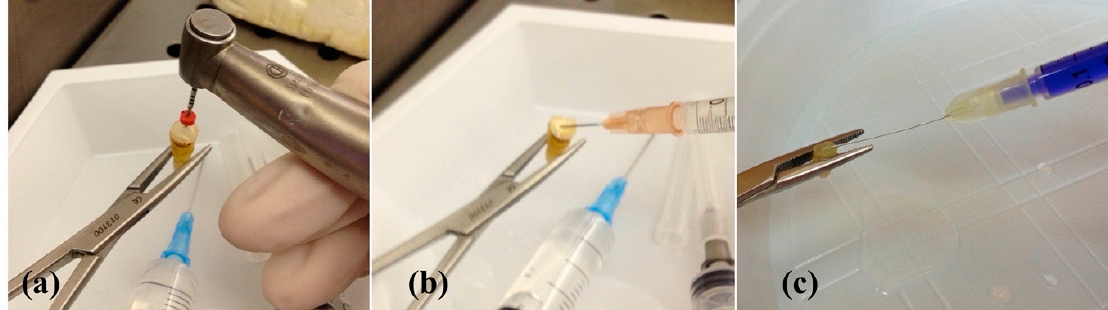
Figure 1. ( a ) Mechanical preparation with a file F2 of the ProTaper® system (Ø = 0.25 mm); ( b ) irrigation of a root canal with 5% of sodium hypochlorite (NaOCl); ( c ) application of 15 μ g/mL of Toluidine Blue (TB).